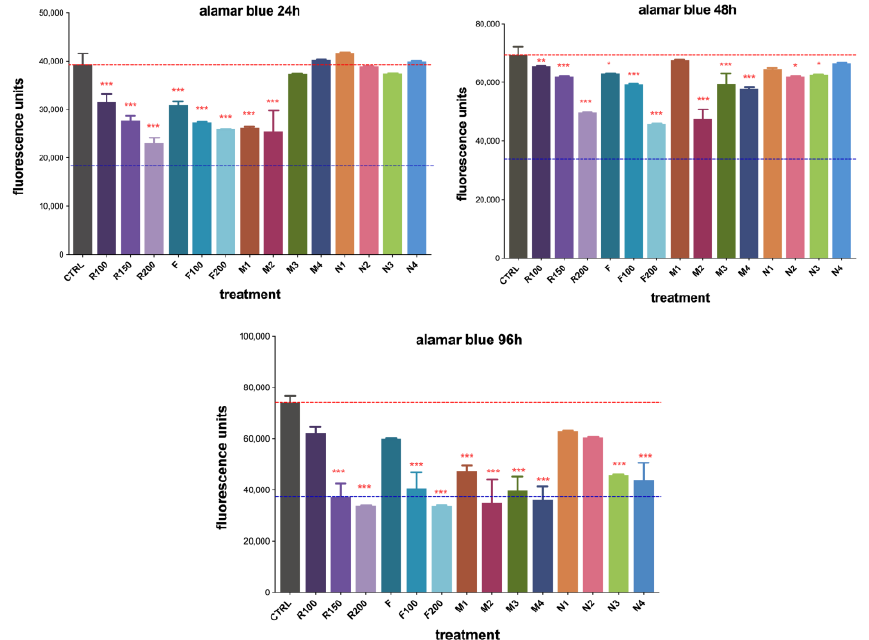
Figure 10. Alamar Blue viability assay of C6 glioma cells cocultured with polymers for 24, 48, and 96 h (*** p < 0.001; ** p < 0.01; * p < 0.05). Legend: CTRL = untreated control; R100/150/200 = free RUX in PBS 100/150/200 µM; F = plain fibrin hydrogel; F100/200 = RUX loaded fibrin gel 100/200 µM; M1–4 = RUX loaded MIPs 1–4; N1–4 = nonimprinted NIPs 1 – 4.